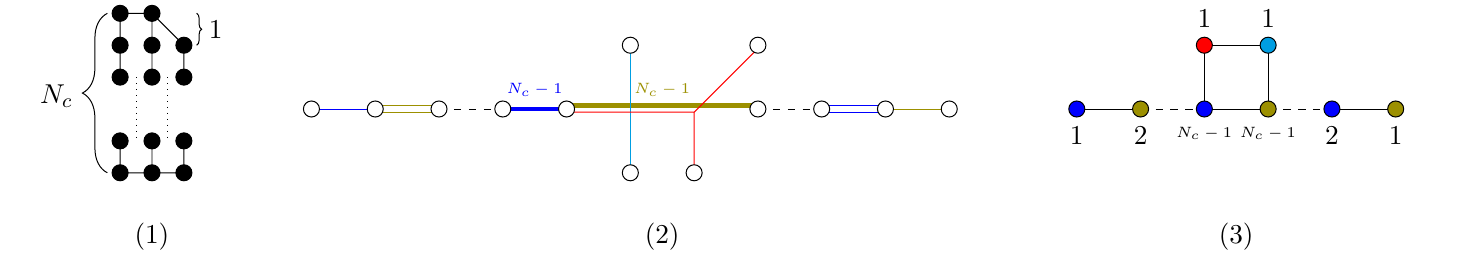
1 at finite gauge coupling where masses are set to zero. (2) Brane Web −